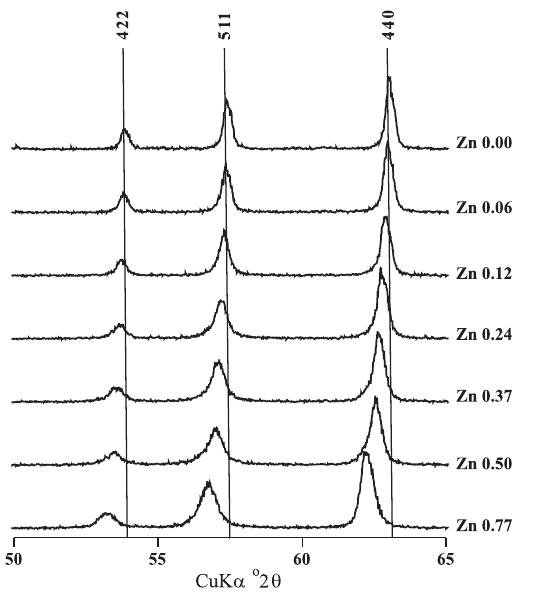
Figure 3. Mean crystallite dimension (MCD) of synthetic maghemites with different Fe 3+ for Zn 2+ substitution